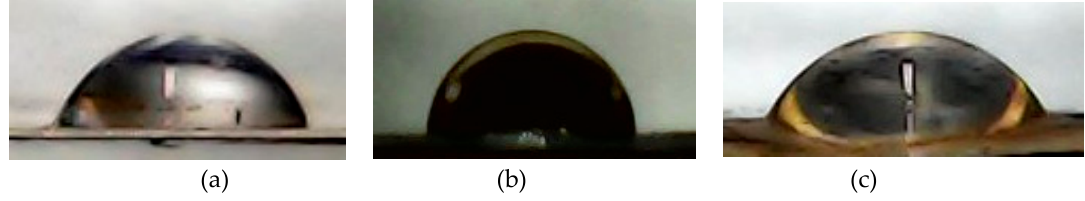
Figure 5. Images of water drops on membranes: ( a ) PA-PSL; ( b ) PA+0.25Cu-PSL; ( c ) PA+0.25Fe-PSL.